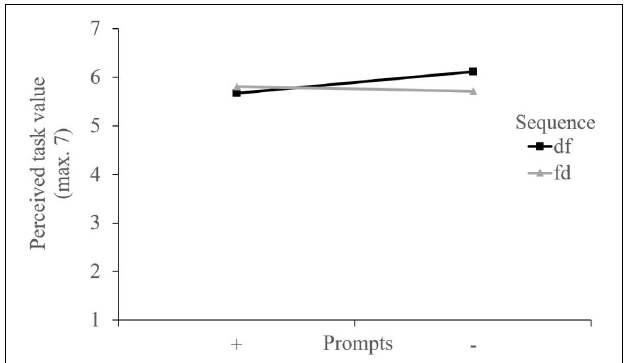
FIGURE 6 | Interaction plot regarding perceived task